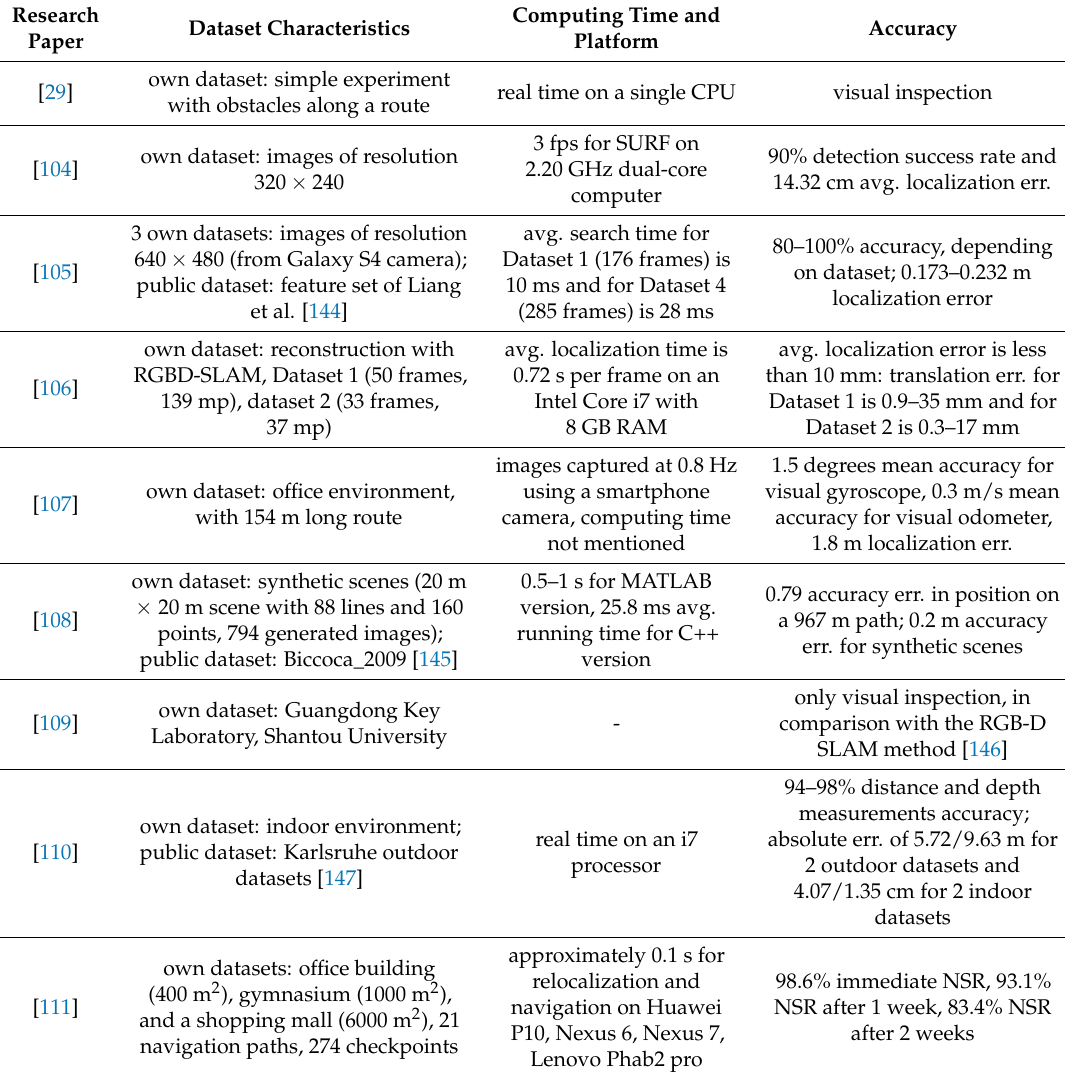
Table 14. Characteristics of indoor localization solutions with an existing/generated 3D model of the environment, 2D mobile cameras, real features, and traditional image